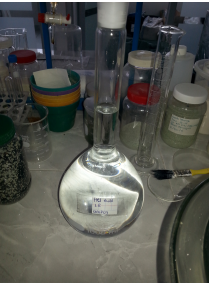
Figure A5. Total volume to be used (3084